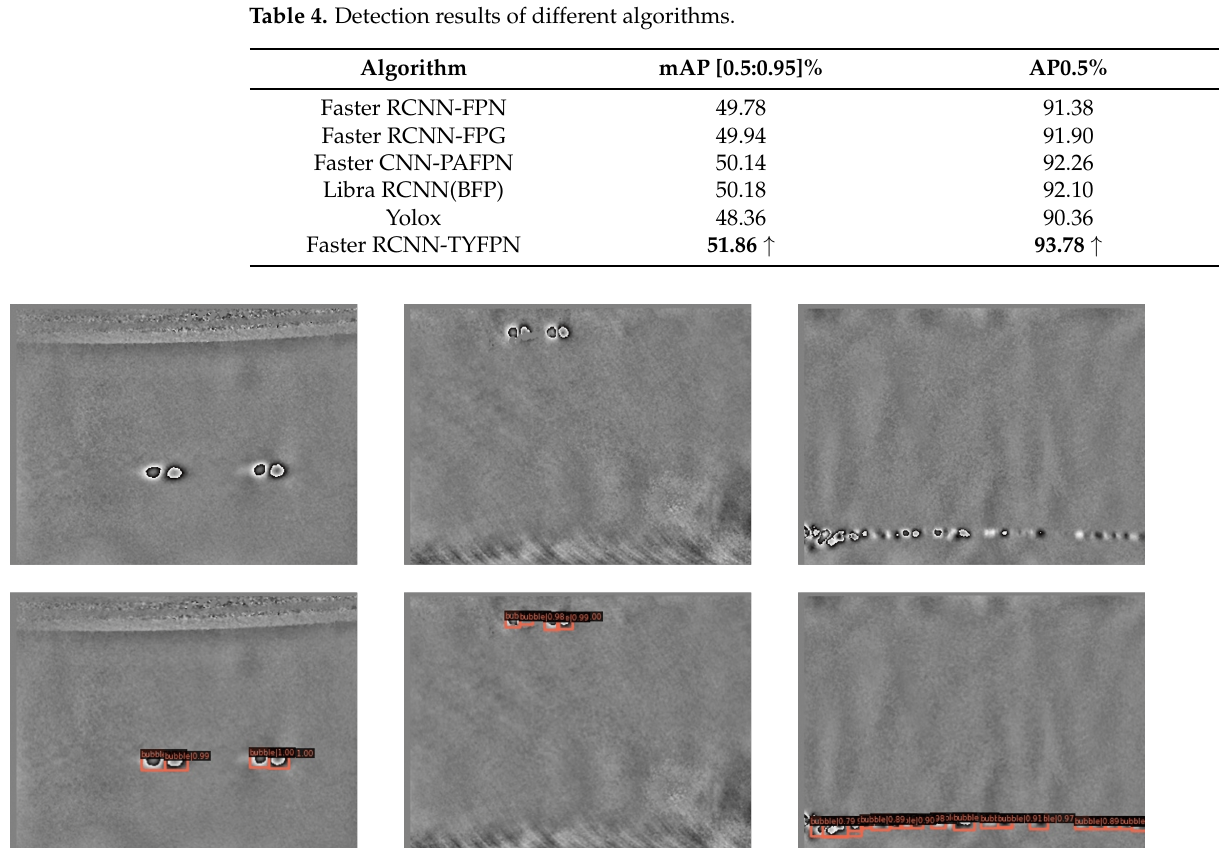
Figure 9. Tire bubble defect images and detection results. The upper part is the picture with defects, and the lower part is the corresponding detection result, including the predicted defect location, boundary, and probability.